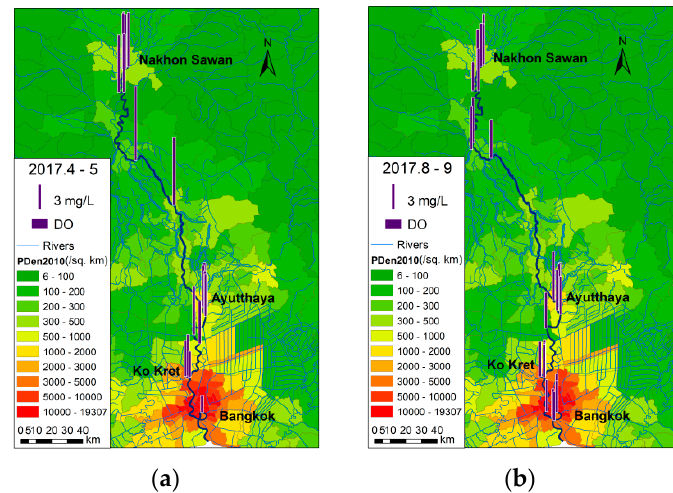
Figure 2. DO distributions at the beginning ( a ) and in the second half ( b ) of the wet season.